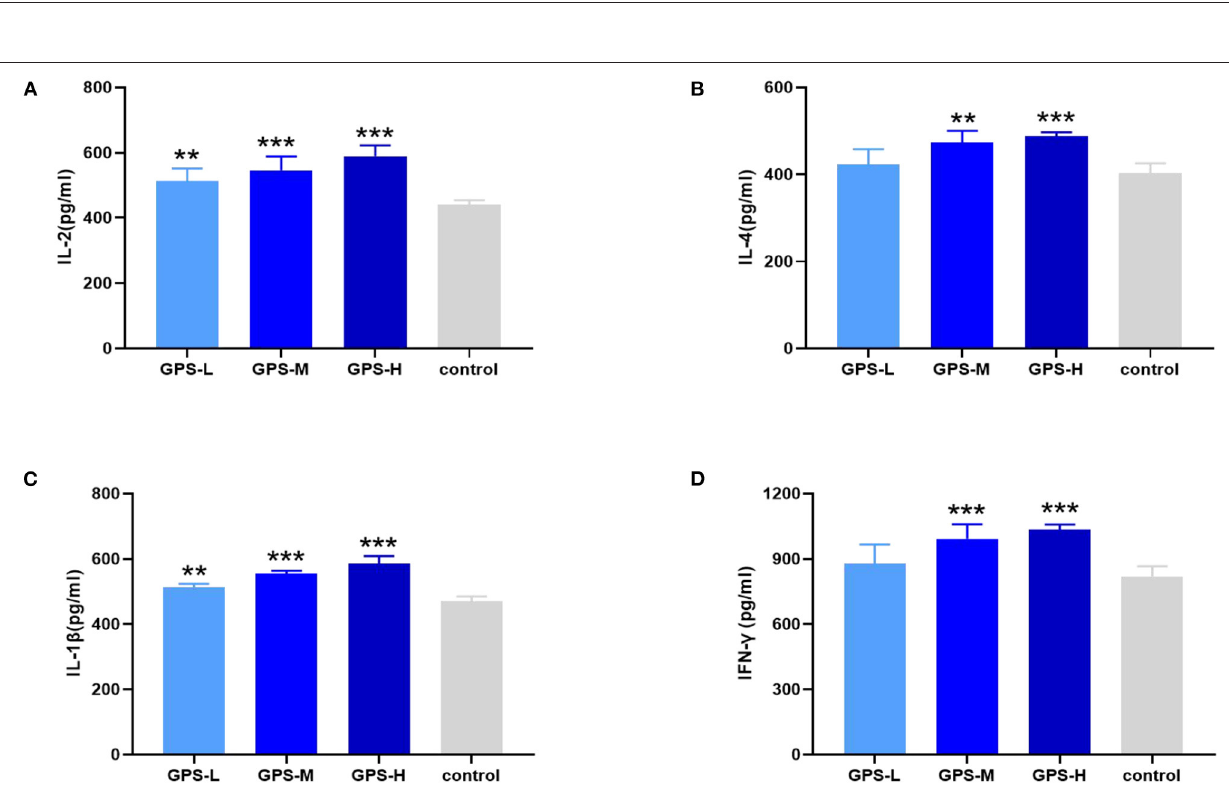
Frontiers in Veterinary Science |